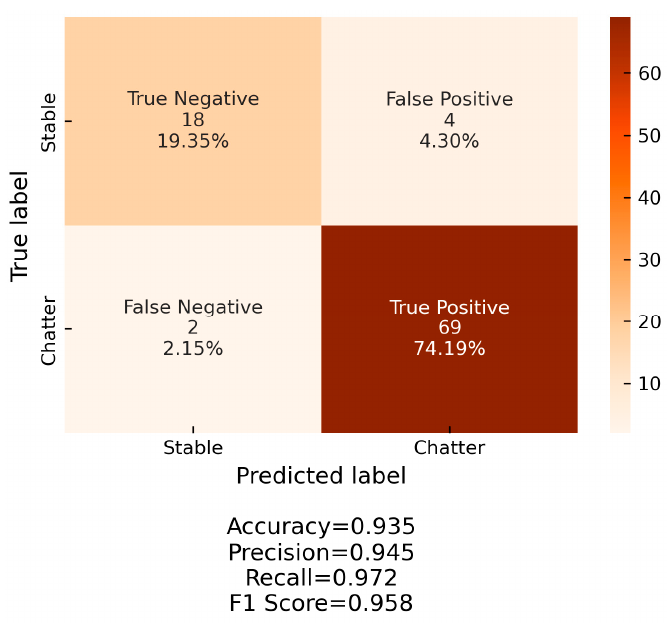
Figure 12. ROC curve of chatter detector.